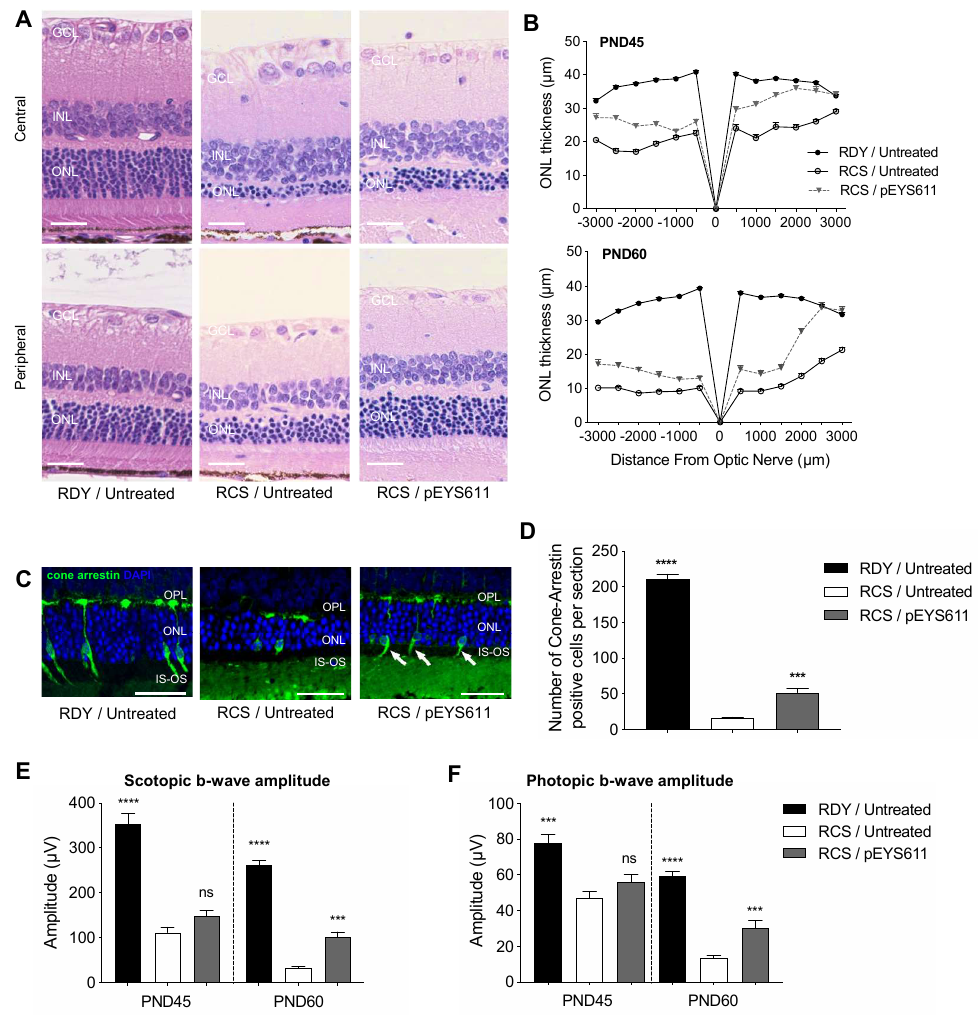
Figure 9. pEYS611 preserves retinal structure and function in RCS rats. At PND18, RCS rat received a bilateral injection and electrotransfection of pEYS611 in the ciliary muscle at the dose 25 µ g / eye. Non-dystrophic RDY rats were used as the control and were left untreated. On PND45 and PND60, animals were sacrificed for histological examinations. ( A ) Representative images of hematoxylin / eosin-stained central (top) and peripheral (bottom) superior retina at PND60. ( B ) ONL thickness was measured every 500 µ m from the optic nerve (0) to the inferior ( − ) and superior ( + ) poles of the retina. ( C ) Representative images of cone-arrestin staining in peripheral superior poles of the retina at PND60 (cone arrestin in green / DAPI in blue). ( D ) Number of cone-arrestin-positive cells per section in the whole retina was drastically reduced in RCS / untreated rats compared to RDY normal rats at PND60. pEYS611 treatment significantly preserved cones. *** p < 0.001; **** p < 0.0001 using Tukey’s multiple comparisons test versus RCS / untreated group. ( E , F ) Light- and dark-adapted ERG responses were recorded simultaneously from both eyes at PND45 and PND60. Amplitude ( µ V) of scotopic and photopic b-waves from ERG responses elicited by a stimulus intensity of 3 cd · s / m 2 ( E ) and 10 cd · s / m 2 ( F ), respectively, are presented. *** p < 0.001; **** p < 0.0001 using the repeated measure mixed model versus RCS / untreated group. All values are presented as mean ± sem. Scale bar, 25 µ m. GCL, ganglion cell layer; INL, inner nuclear layer; IS: inner segment, ONL: outer nuclear layer, OPL: outer plexiform layer, OS: outer